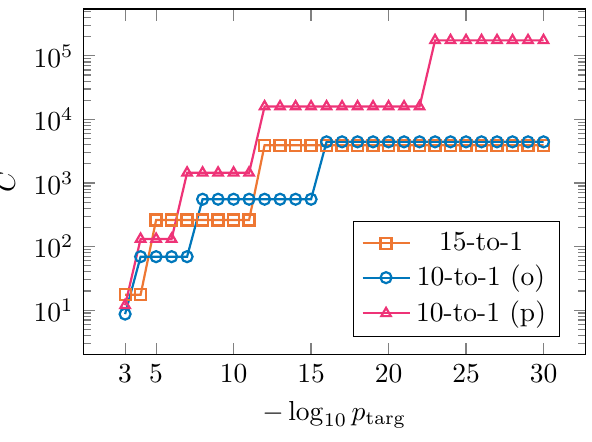
FIG. 19. A plot showing the distillation cost C for different tar- get error rates p targ , assuming an input error rate of p = 0.01. For certain values of p targ , we find that the cost of our 10-to-1 pro- tocol is lower than the cost of the 15-to-1 protocol, where “(o)” and “(p)” refer to the optimistic and pessimistic noise models for CCZ states described in Sec. III B,